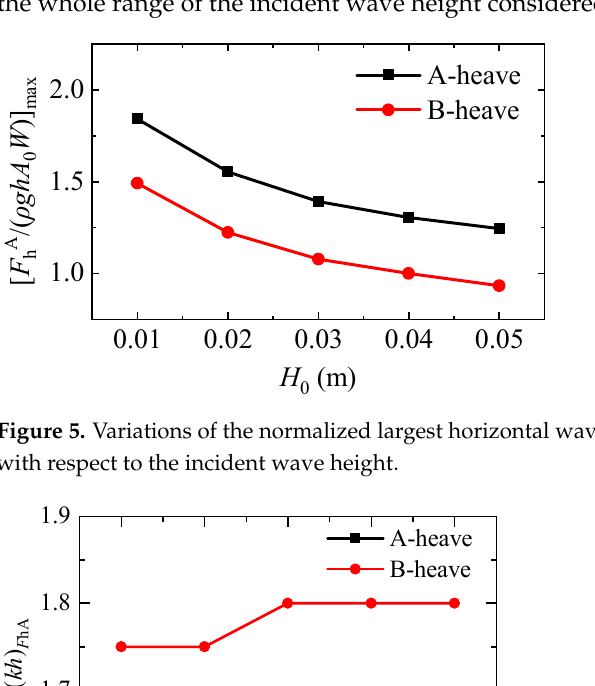
Figure 5. Variations of the normalized largest horizontal wave forces on Box A, [ F hA /( ρ ghA 0 W )] max , with respect to the incident wave height.